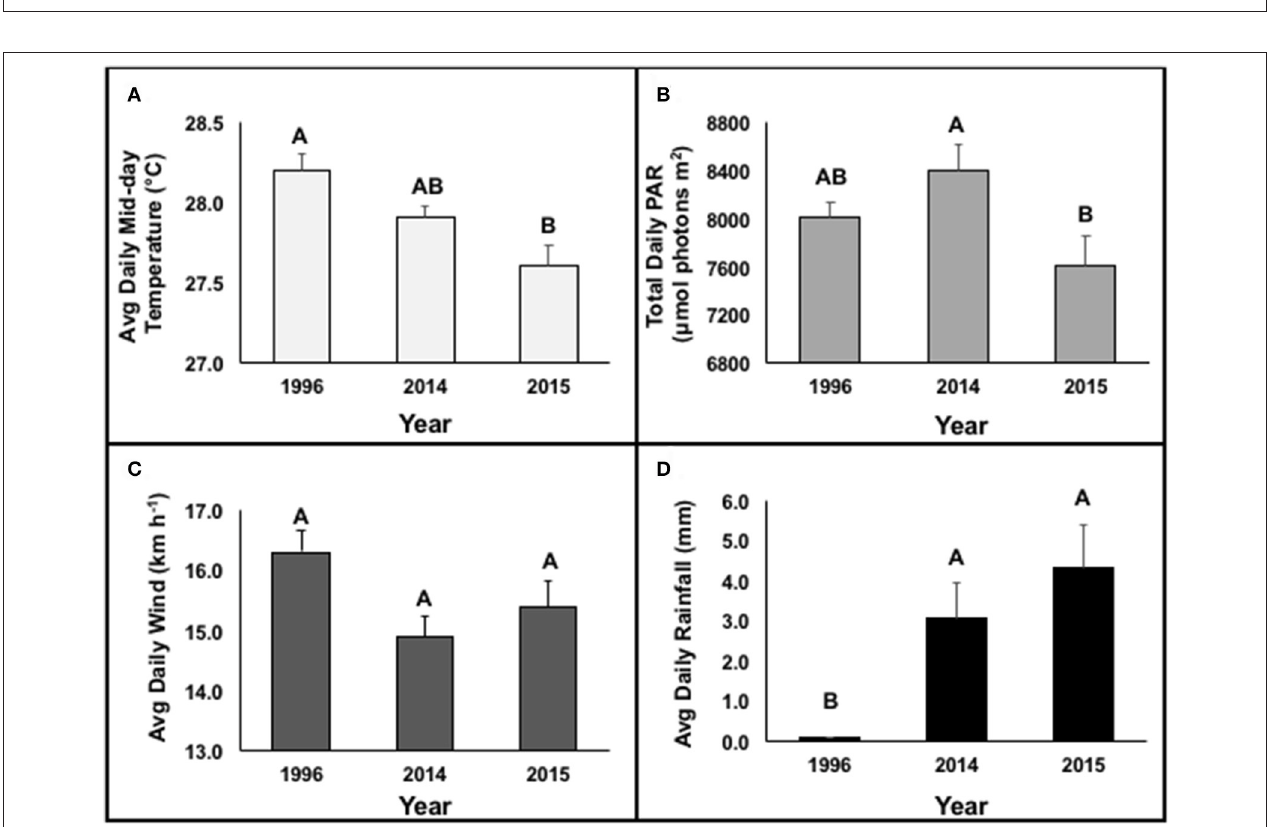
FIGURE 5 | Coral condition (proportion of surveyed area) defined as normal (red), pale (yellow), bleached (white), and dead (black) by flow regime in 1996 (A) , 2014 (B) , and 2015 (C) . Coral condition was averaged across survey months (October and December) for bay-wide bleaching surveys.